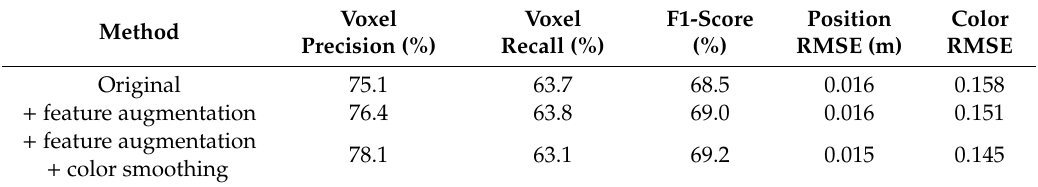
Table 2. Accuracy comparison between di ff erent variations of the Pix2Pix